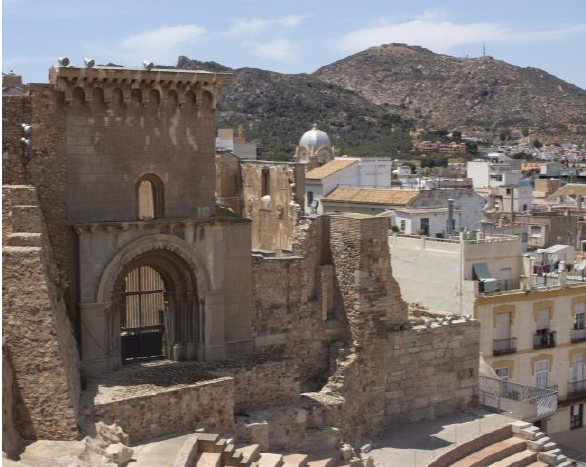
Figure 1. General view of the east facade of the Main Church